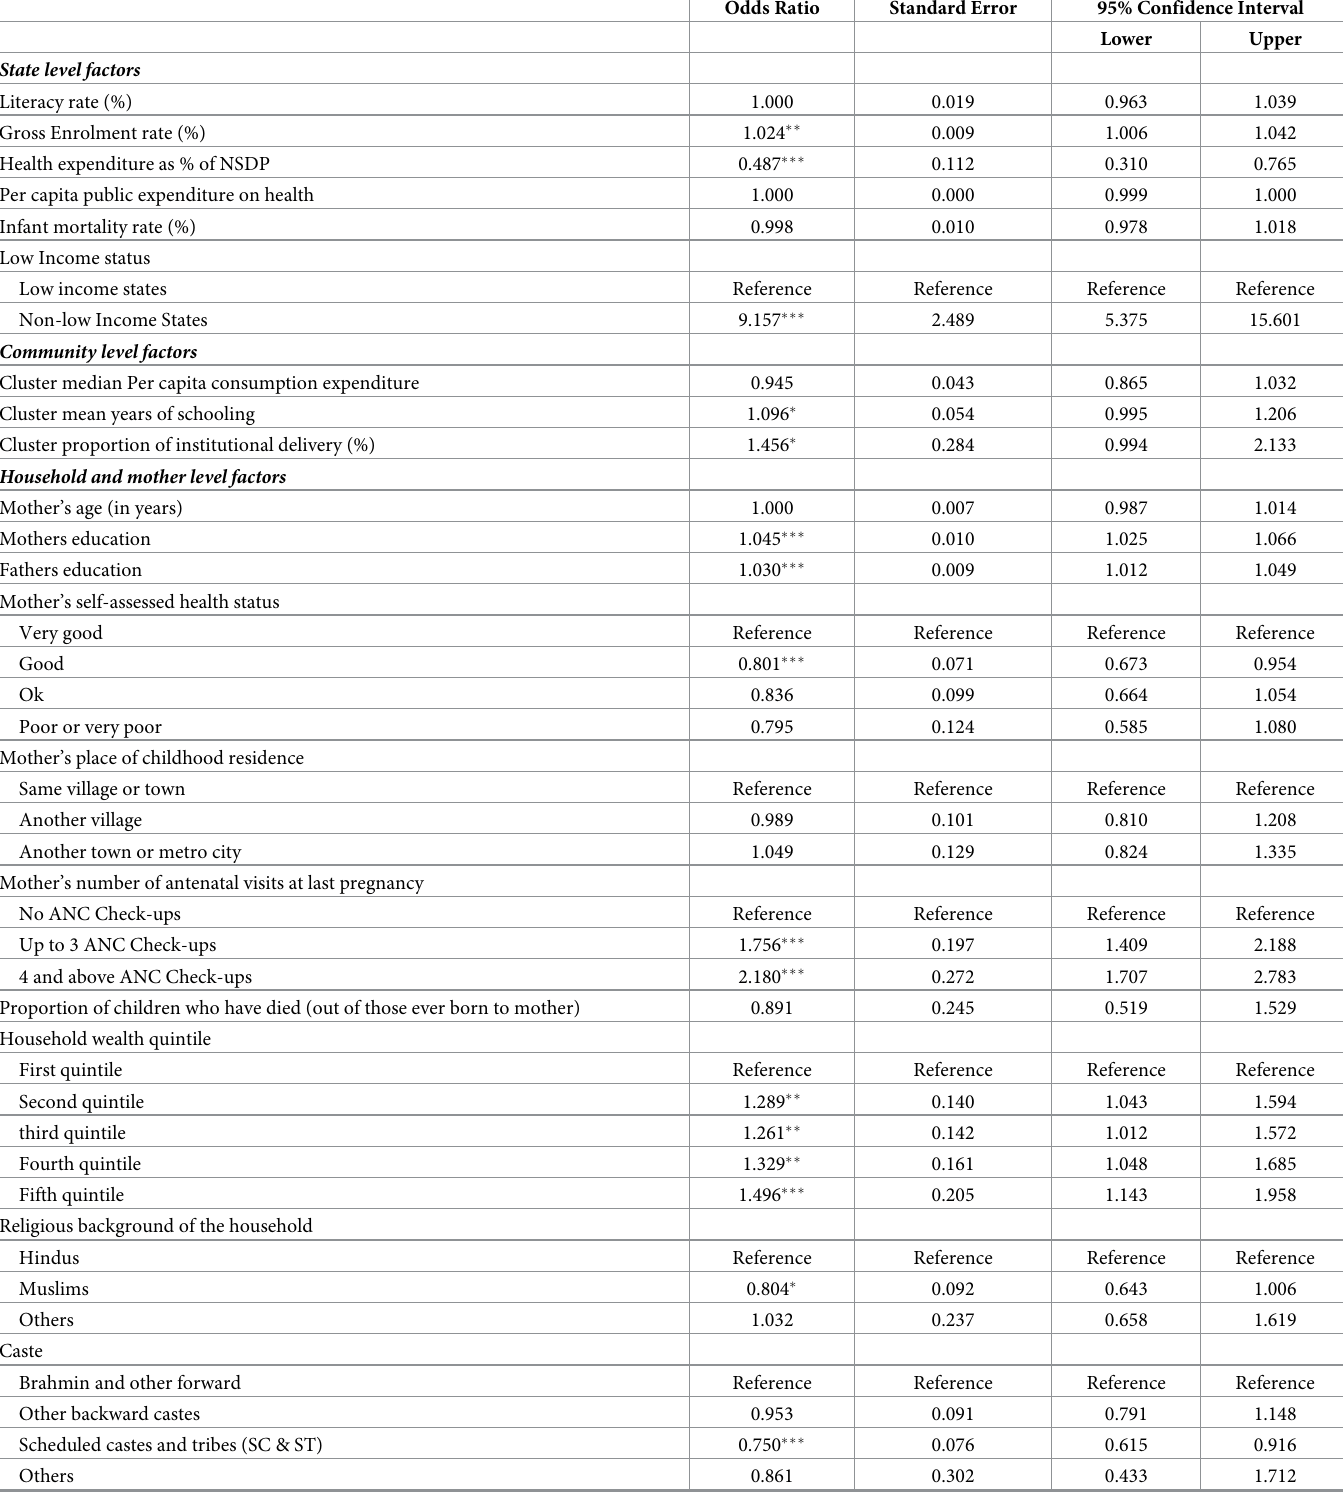
Table 4. The three levels random slope